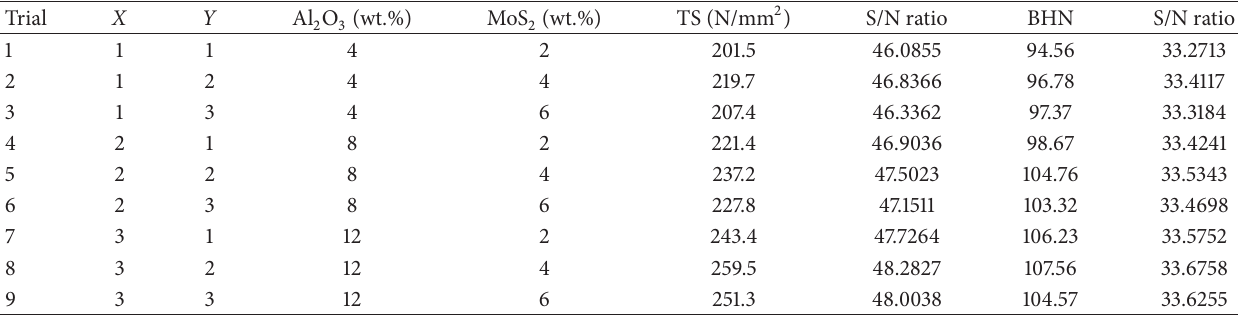
Table 5: Experimental result for tensile strength of Al6061/Al 2 O 3 /MoS 2